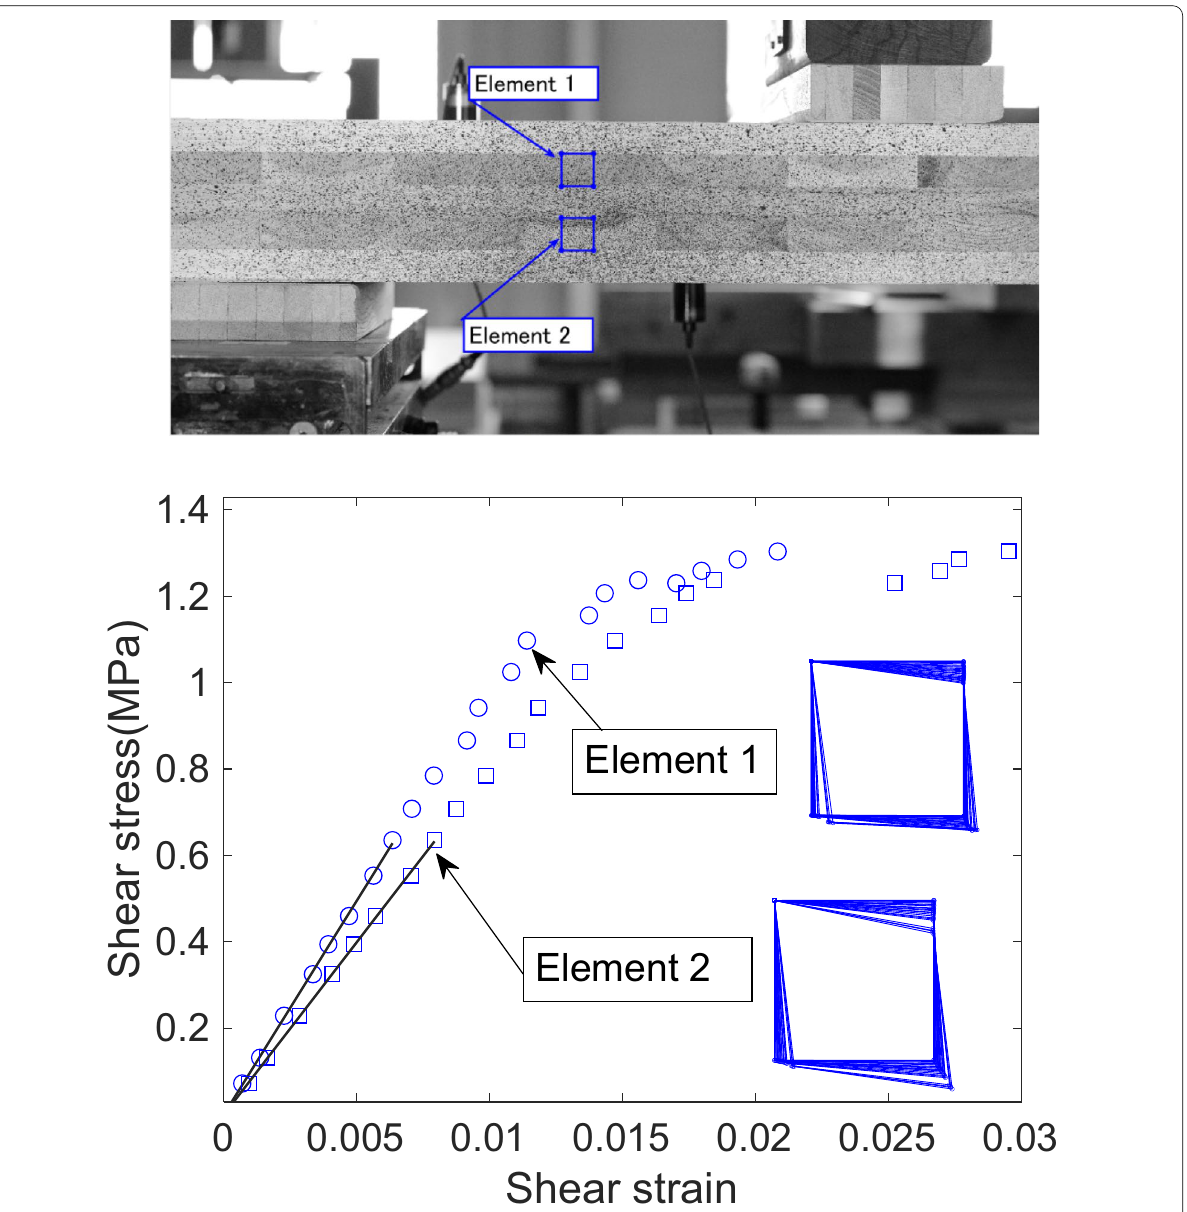
Fig. 12 Sample shear stress–strain curve obtained from the experiment. Shear stress is estimated by multiplying α mid (see Fig. 11) with the nominal shear